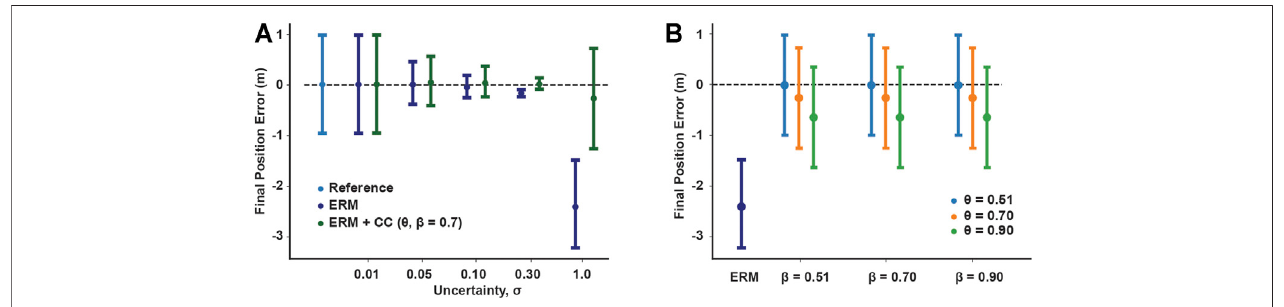
FIGURE 5 | Effects of chance constraints on robustness of sliding block controls in open loop simulations. (A) Mean and range of fi nal position errors for the ERM with and without chance constraints planned under different uncertainties, compared to those of the reference. The addition of chance constraints maintains the low range of fi nal position errors produced by the ERM, but at high uncertainty the chance constraints reduce the average fi nal position error. (B) Mean and range of fi nal position error of simulated chance constraint controls under different risk tolerances compared to the mean and range for the ERM under the highest friction uncertainty case ( σ (cid:2) 1.0). Increasing the upper risk bound β has little effect, while increasing the lower risk bound θ can increase the average fi nal position